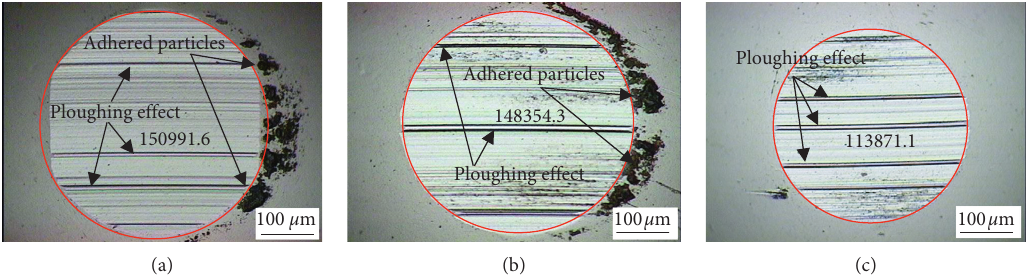
Figure 8: Wear scars on the WC ball used to test samples: (a) RAW, (b) CQT, and (c) LQ for a sliding distance of 500 m. Notice the lack of adhered particles for LQ